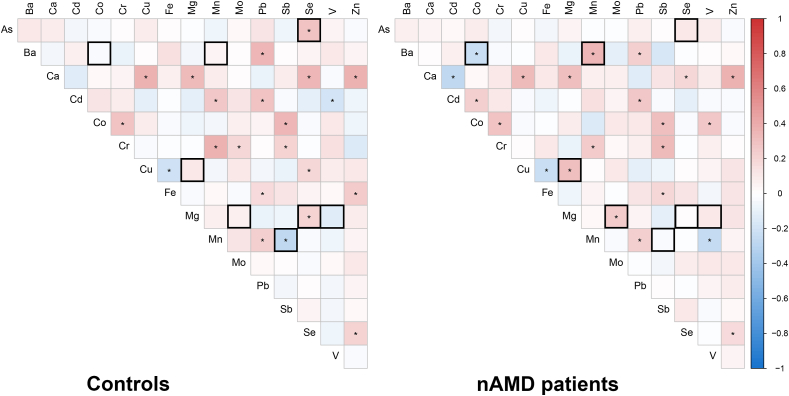
Spearman's correlation between plasma trace elements in nAMD patients and controls. Left-hand side: Correlations are depicted as observed in the controls. Right-hand side: Correlations in nAMD patients. Colors indicate positive (red) and negative (blue) correlations between the different trace elements, and significant correlations (PFDR-value <0.05) after FDR correction are indicated with an asterix (*). Black bordered squares are those correlations that were significantly different between nAMD patients and controls (Table 3). Supplementary Table 2 provides all plasma trace element correlations in nAMD patients and controls in more detail. Abbreviations: As, arsenic; Ba, barium; Ca, calcium; Cd, cadmium; Co, cobalt; Cr, chromium; Cu, copper; Fe, iron; Mg, magnesium; Mn, manganese; Mo, molybdenum; nAMD, neovascular age-related macular degeneration; Pb, lead; Sb, antimony; Se, selenium; V, vanadium; Zn, zinc. (For interpretation of the references to color in this figure legend, the reader is referred to the Web version of this article.)